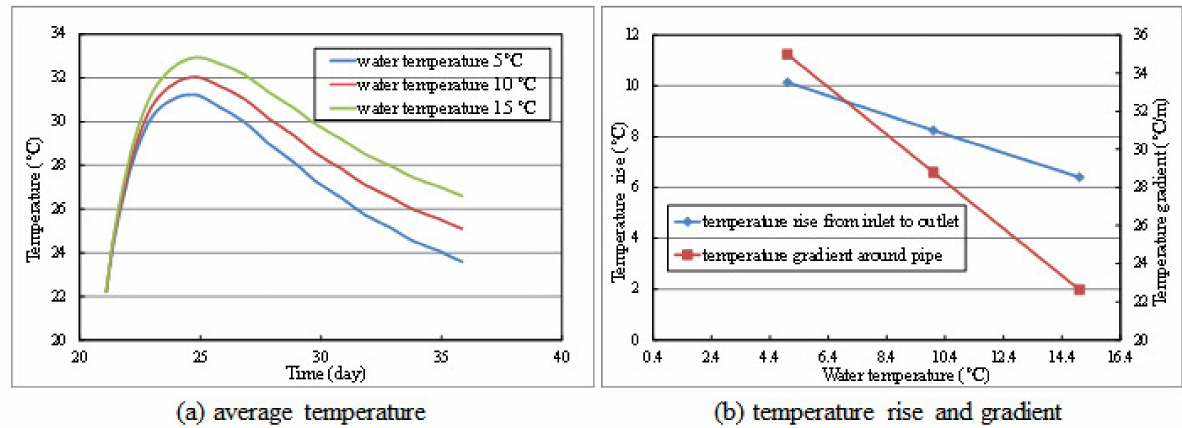
Figure 9. The calculation results of layer 2# under different water temperature: ( a ) average temperature, ( b ) temperature rise and